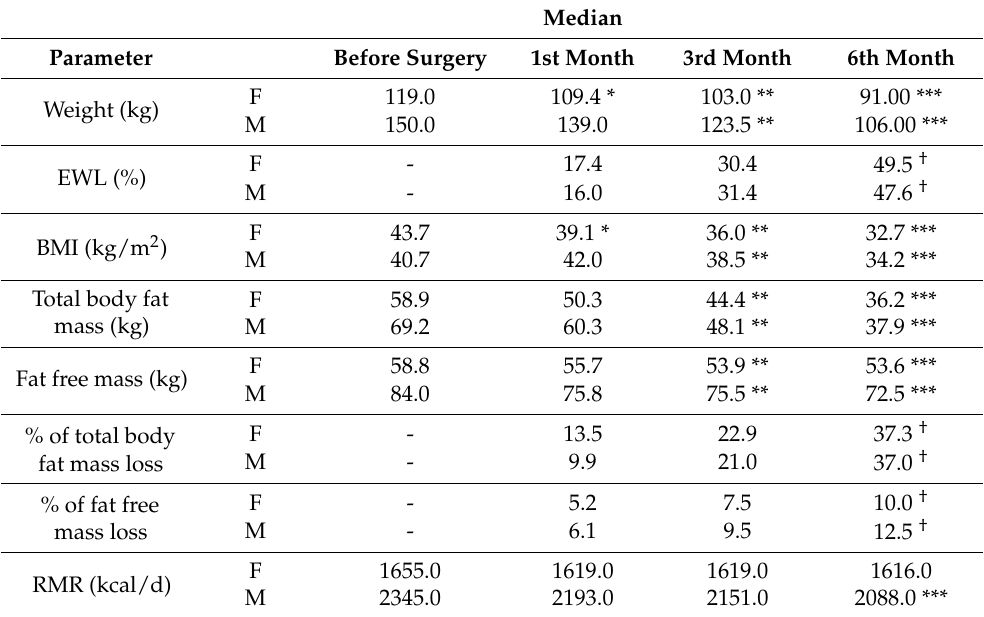
Table 1. Changes in body composition 1, 3, and 6 months after LSG in the group of women and men.